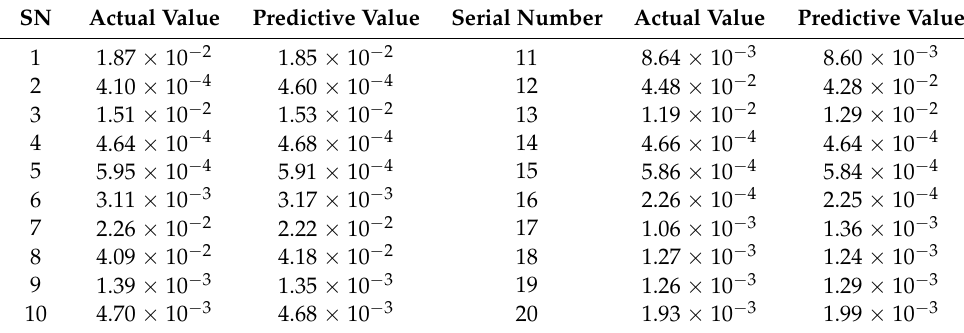
Table 5. Prediction results of the test samples.